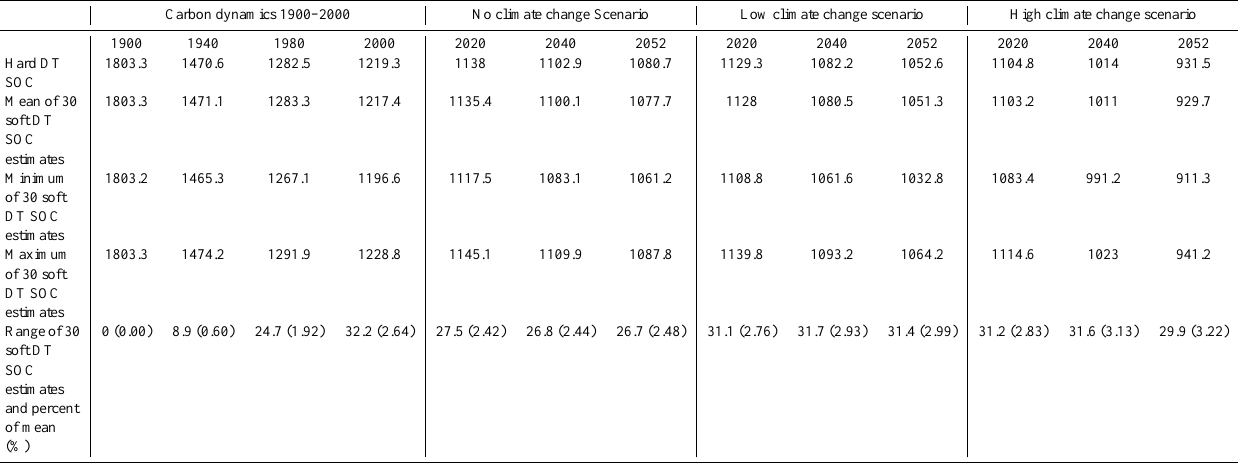
Table 7. Summary statistics of the mean study area hard and soft decision tree (DT) soil organic carbon (SOC) (gC/m 2 ) model estimates illustrated in Figs. 7 and 8, for the no , low and high climate change scenarios, for selected